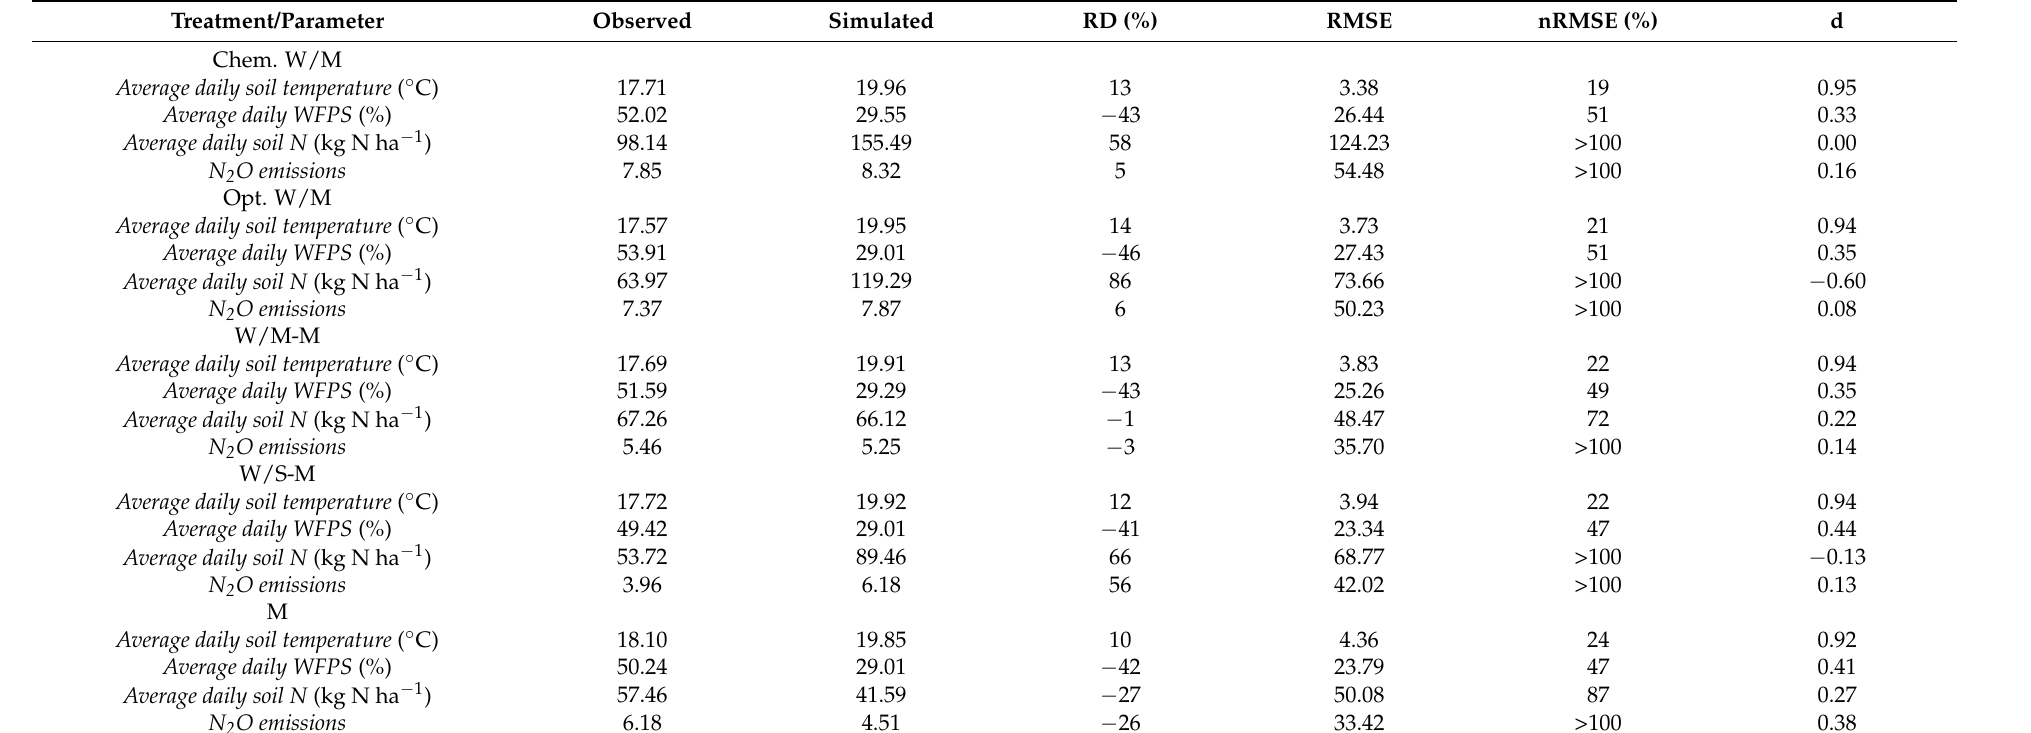
Table 1. Statistical evaluations of simulated daily soil temperature, WFPS, soil nitrogen and cumulative N 2 O fluxes compared with the observed values under different cropping